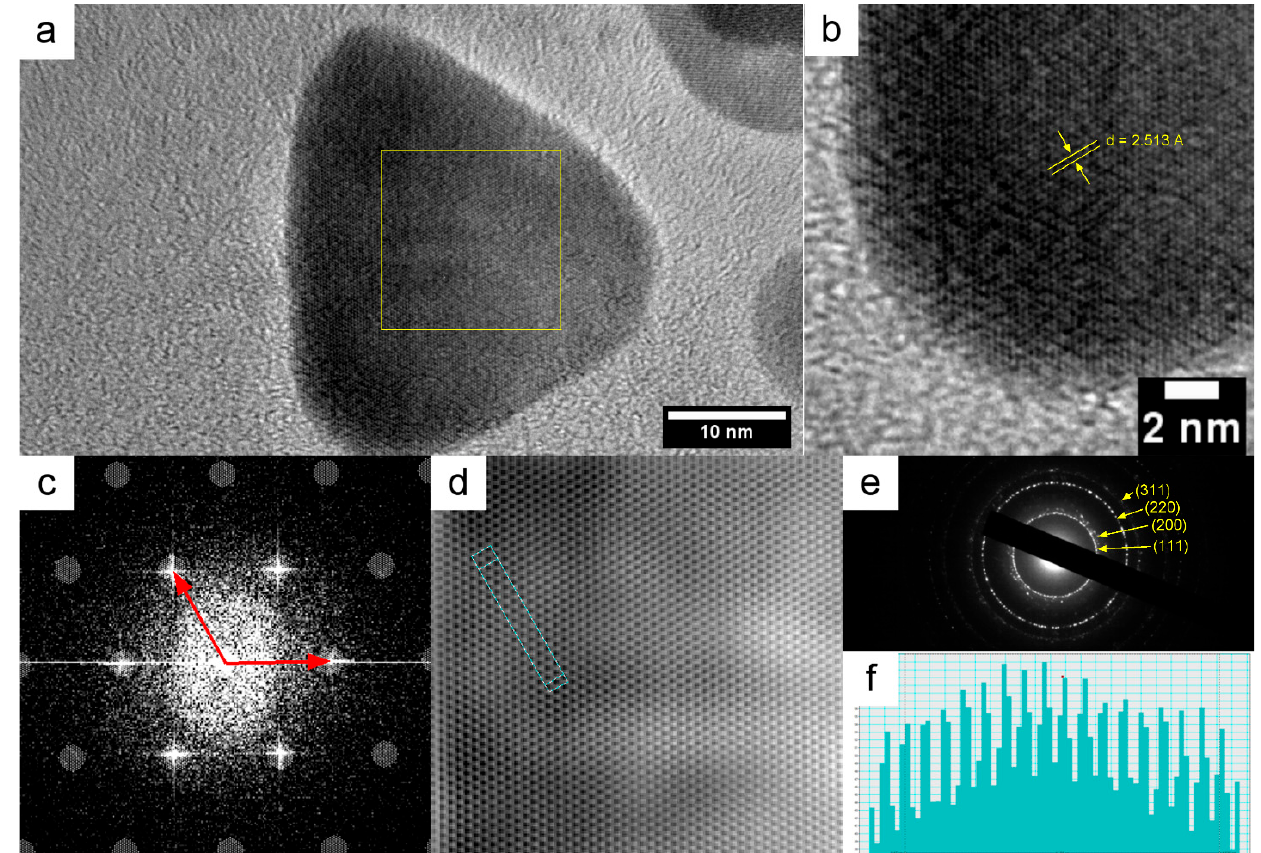
Table 2. Comparison of interplanar spacing as determined by electron diffraction of the Ag NPs. Sample